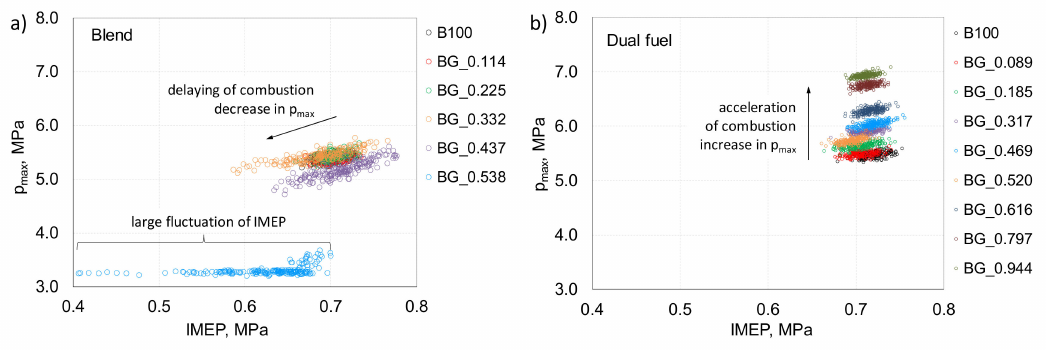
Figure 11. Results of peak pressure vs. IMEP are presented for blends ( a ) and dual fuel ( b ) combustion modes.